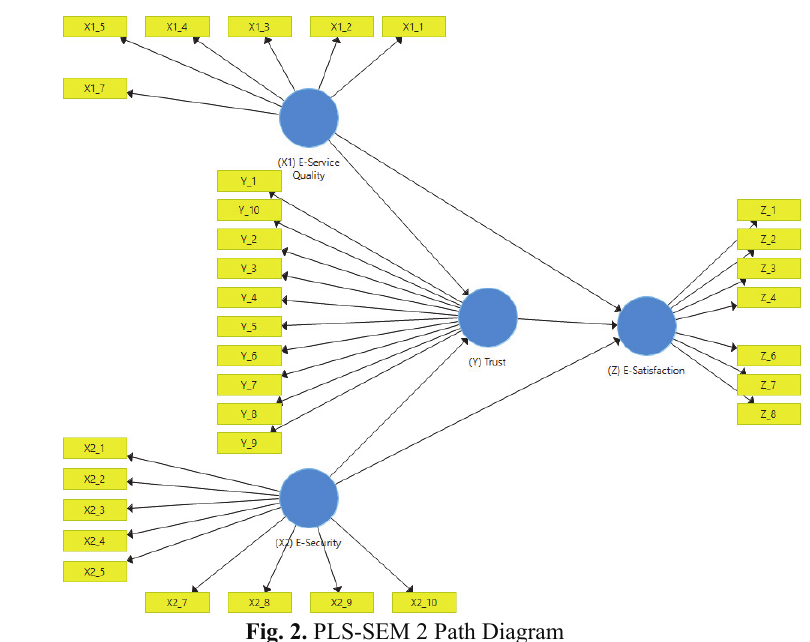
Fig. 2. PLS-SEM 2 Path Diagram